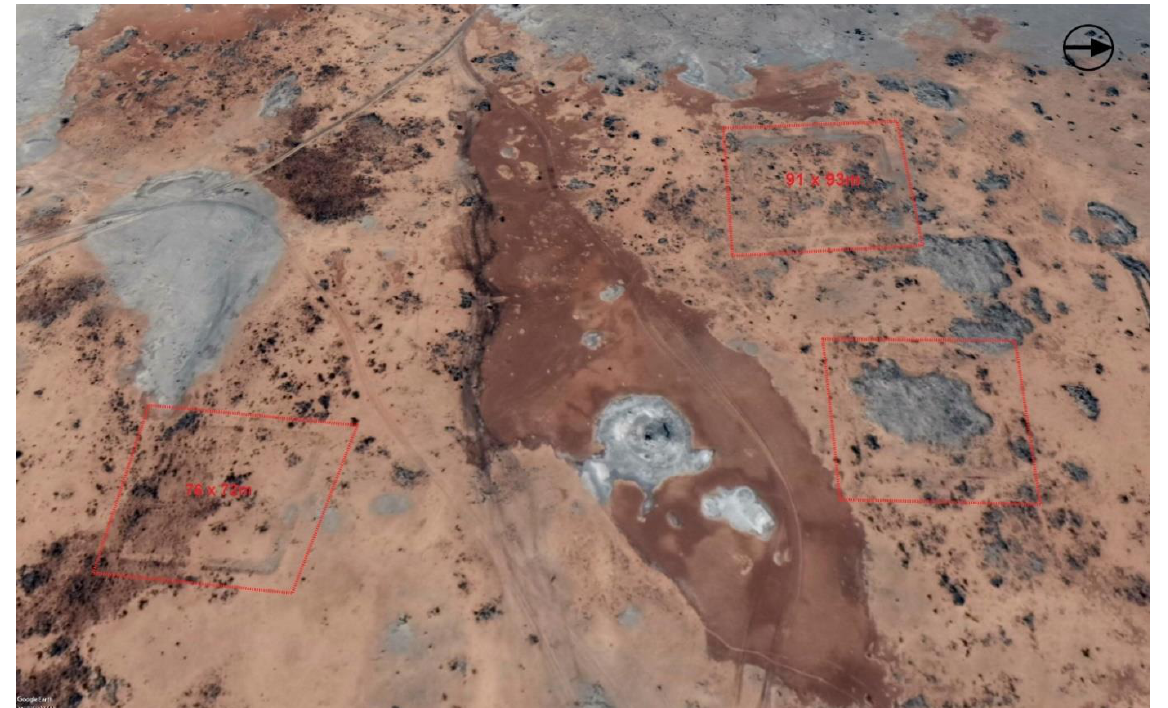
Figure 9: Three further auxiliary fort or stratopedon north of Ar-Rafi'ah in an oblique view from the East, also equipped with titulum. (Google / Maxar Technologies 2021) Ar-Rafi'ah is also located at the eastern end of the Ghouta meadow lakes 117 . Due to its beauty,